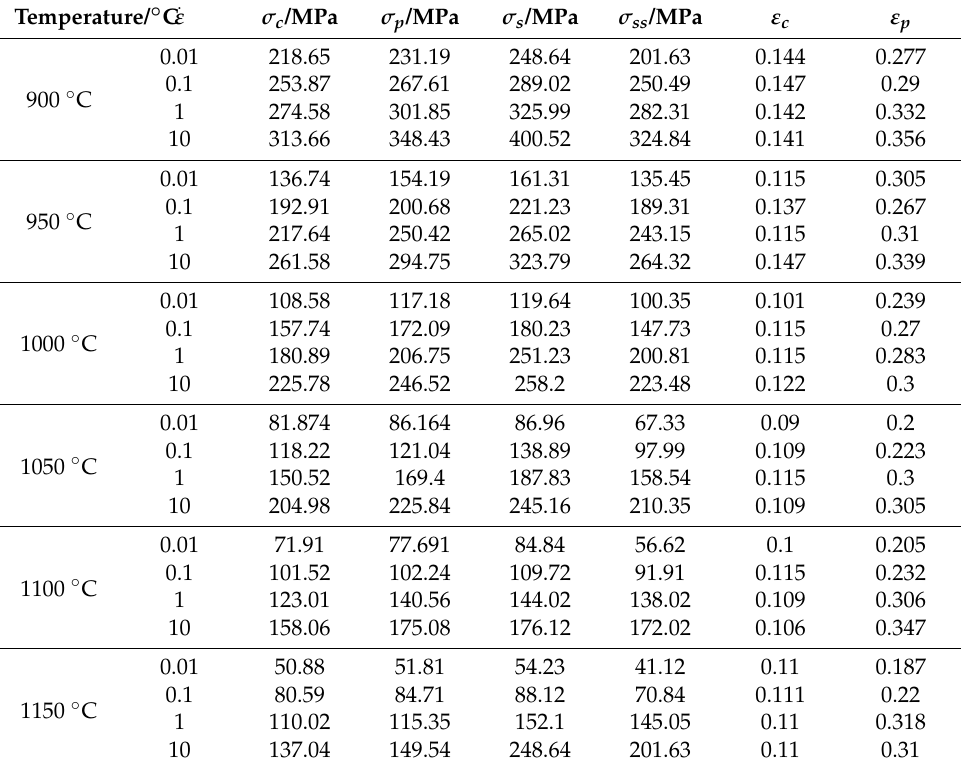
Figure 3. Work hardening rate curve. Table 2. The values of the various parameters.